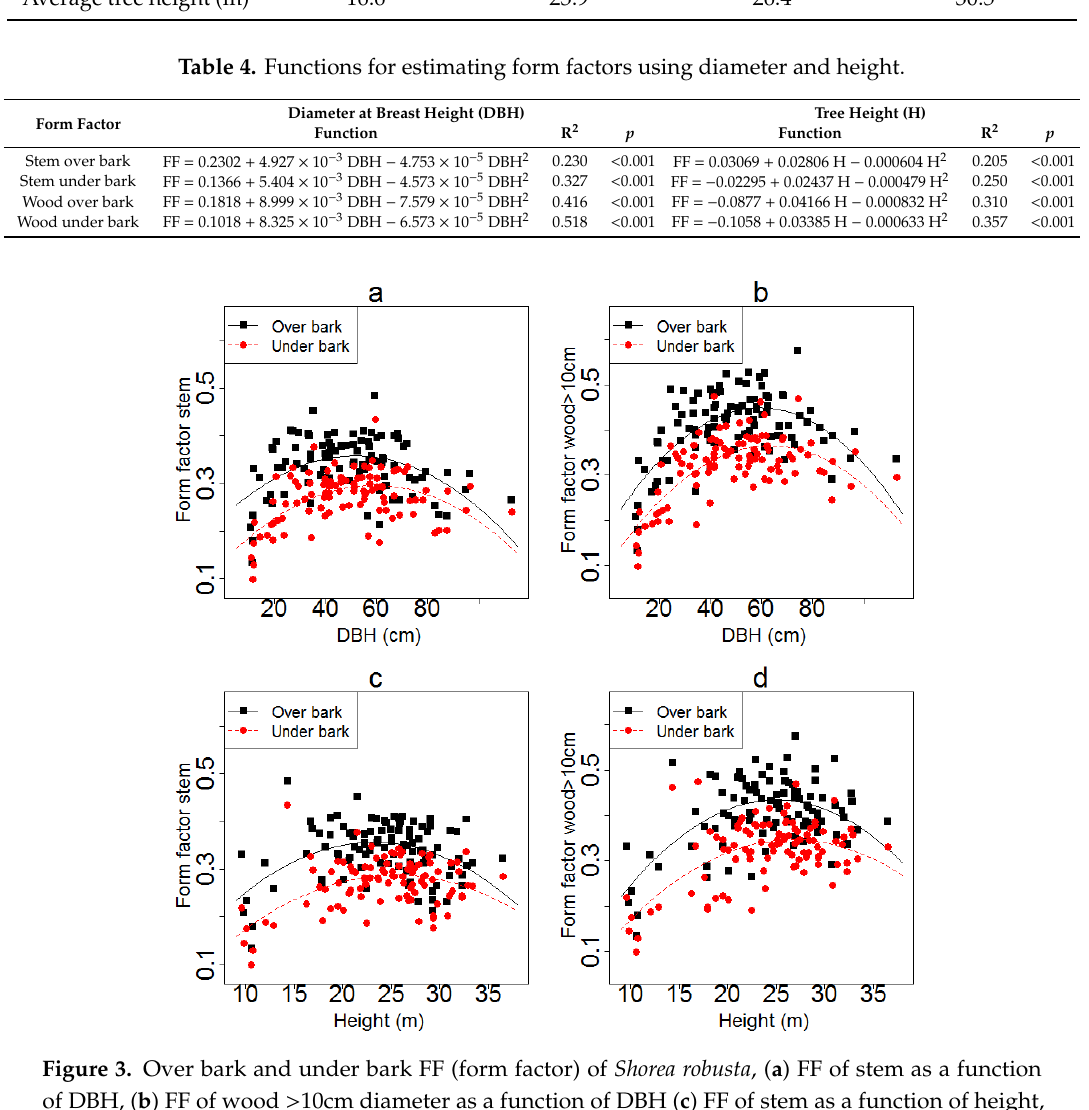
Table 4. Functions for estimating form factors using diameter and